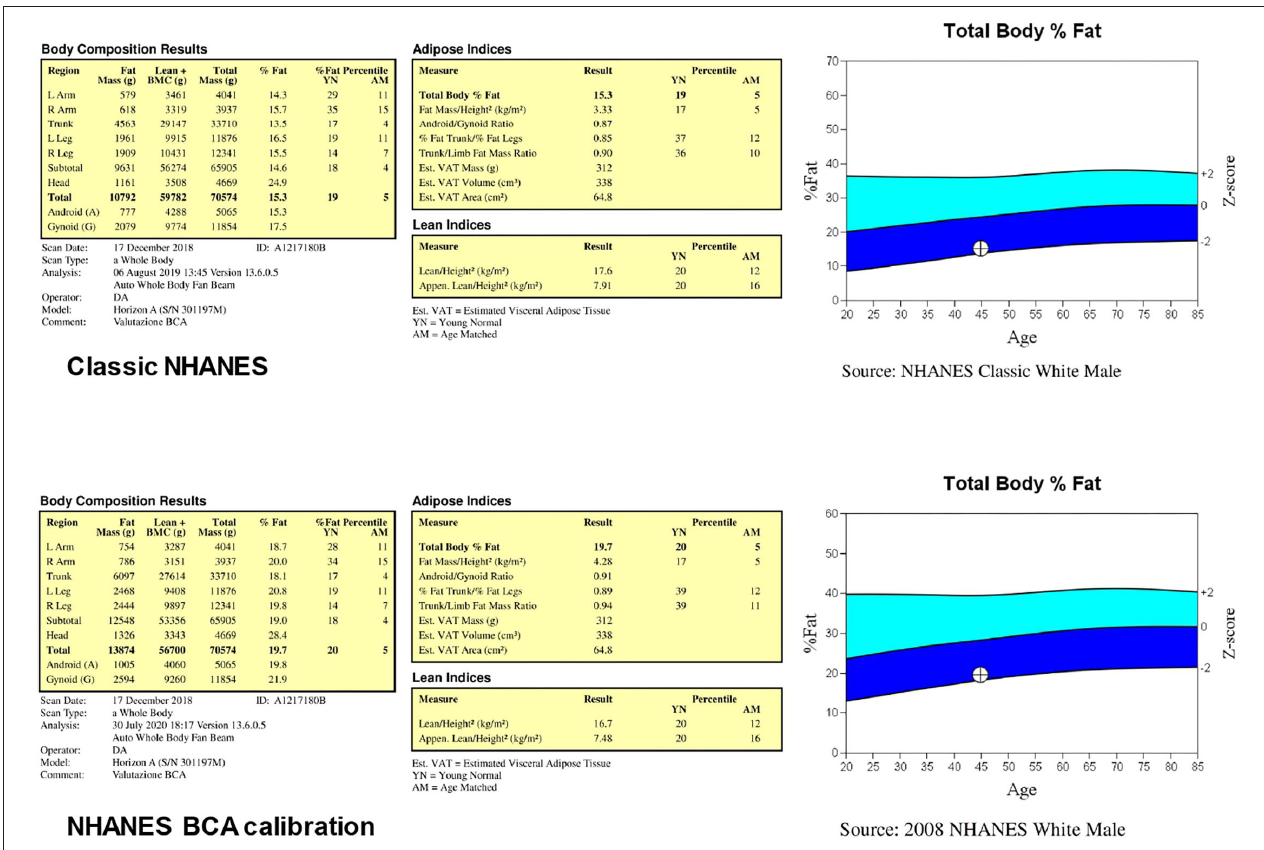
FIGURE 2 | Results of the body composition analyses performed (for the same subject of Figure 1 ) through the two body composition calibration methods called “classic NHANES” and “NHANES BCA calibration”.